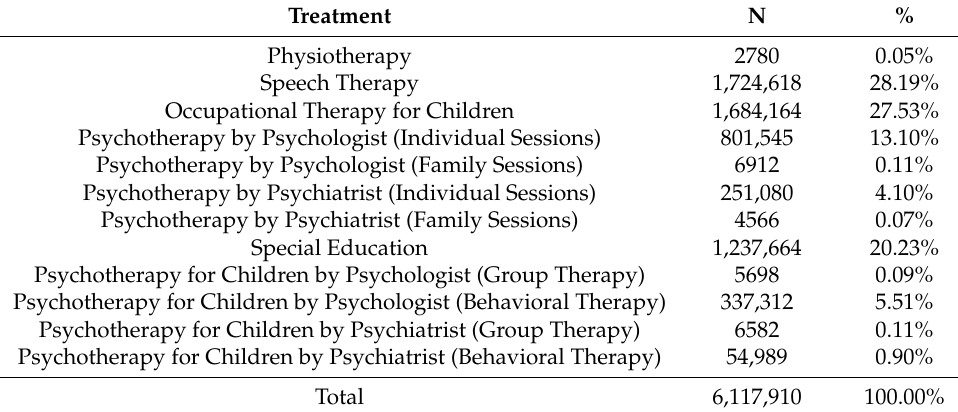
Table 6. Number of ASD therapies per treatment.